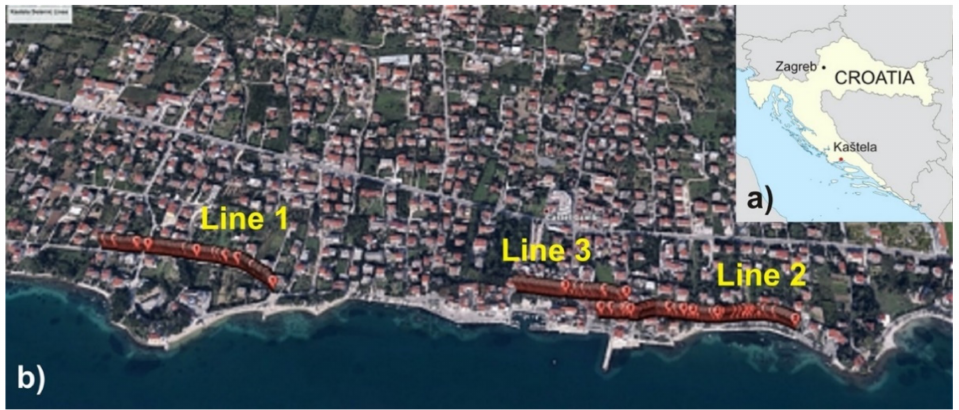
Figure 6. ( a ) Location of the Kaštela City on the Dalmatian coast. ( b ) Position of the seismic lines in the historic center of Kaštela